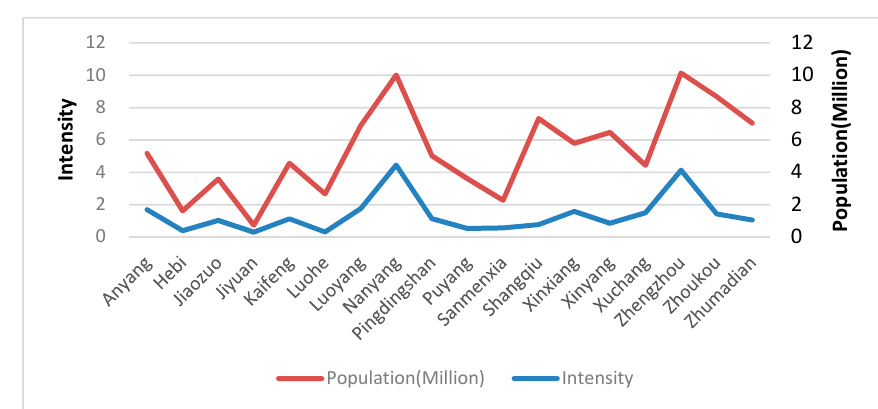
Figure 8. The relationship between population and intensity.